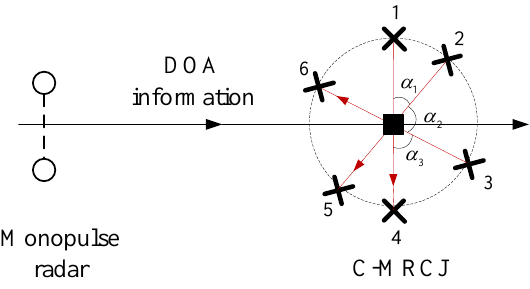
Figure 3. DOA information and modulation direction for C-MRCJ with three jammer